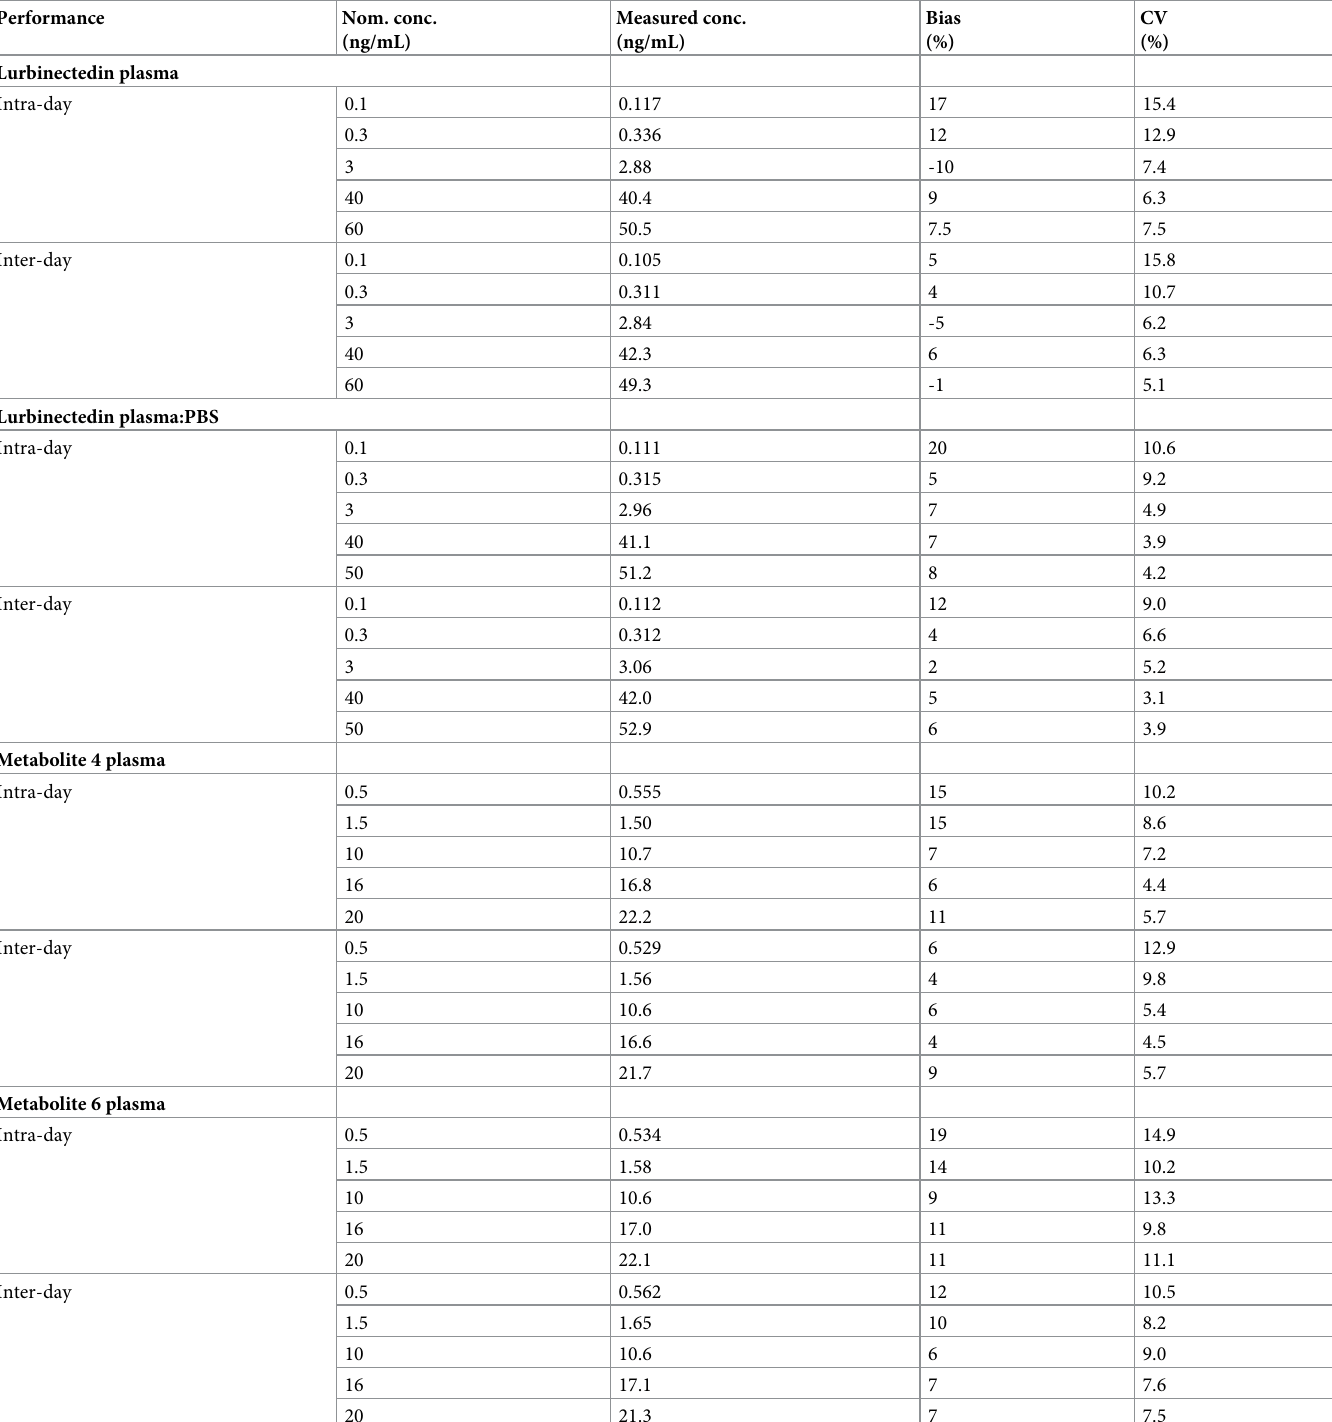
Table 2. Assay performance for the analysis of lurbinectedin in plasma, in plasma:PBS and its metabolites.